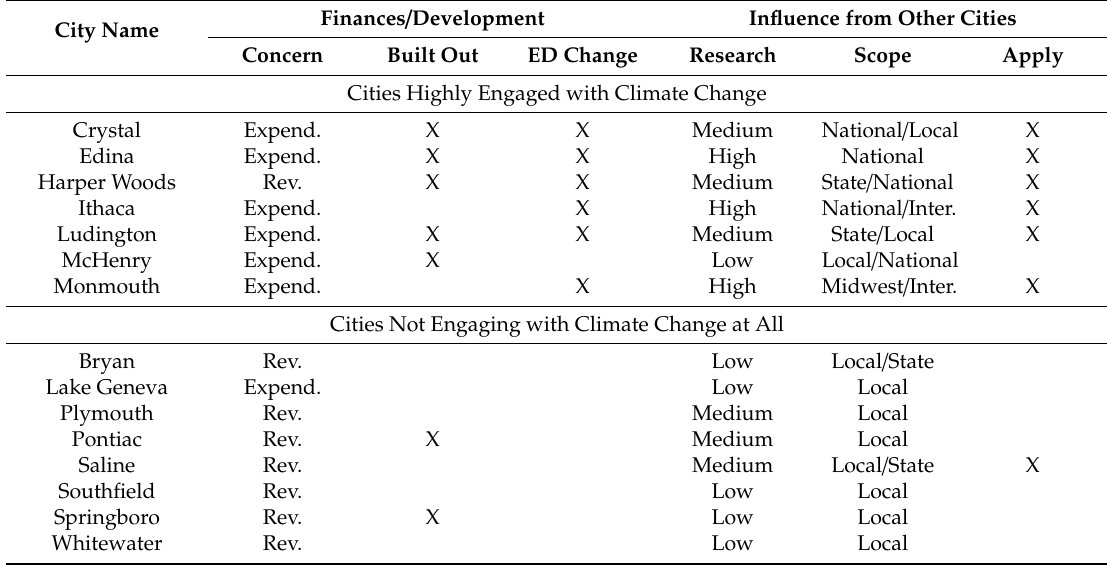
Table 2. Interview coding summary: City political economy and engagement with climate